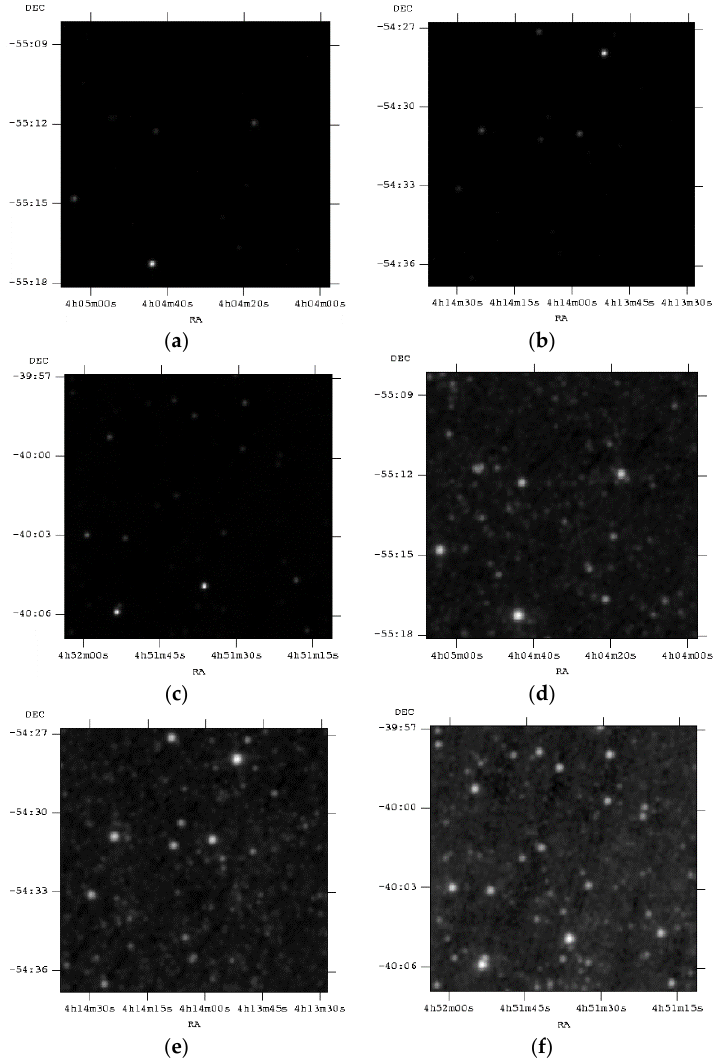
Figure 4. Actual space scene of the Wide ‐ field Infrared Survey Explorer in the W2 band (4.36 μ m): the upper row and lower row figures are the results of linear and logarithmic image compression processing, respectively, of the original space scene. Figure 4 ( a , d ) are located at 61.1362, − 55.2189 J2000; Figure 4 ( b , e ) are located at 63.5123, − 54.5296 J2000; and Figure 4 ( c , f ) are located at 72.9068, − 40.0313 J2000. RA denotes the right ascension, and DEC denotes the declination.